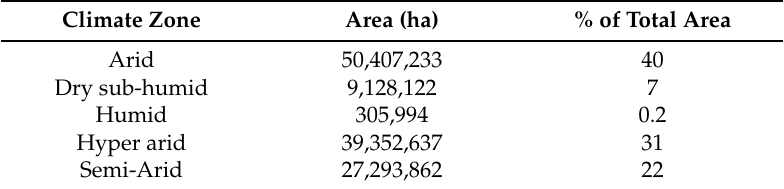
Table 1. Climate zones in Mali.